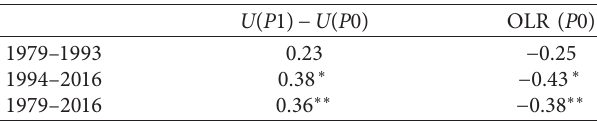
Figure 3: (a) Time series of 5-day running mean 850 hPa zonal wind (m/s) averaged over the South China Sea (110 ° –120 ° E, 10 ° –20 ° N). The black, red, and blue curves are climatological years, typical late-onset years during 1979–1993, and typical early-onset years during 1994–2016, respectively. (b) Time series of the standardized OLR (red; W/m 2 ) in the onset pentad and zonal wind growth intensity ( U ( P 1) − U ( P 0); blue; m/s) over the SCS (110 ° –120 ° E, 10 ° –20 ° N) from 1979 to 2016. Table 1: Correlation coefficients between the anomalies of the zonal wind growth intensity ( U ( P 1) − U ( P 0)) and OLR over the SCS in onset pentad and the SCSSM onset dates in the periods of 1979–93 and 1994–2016,